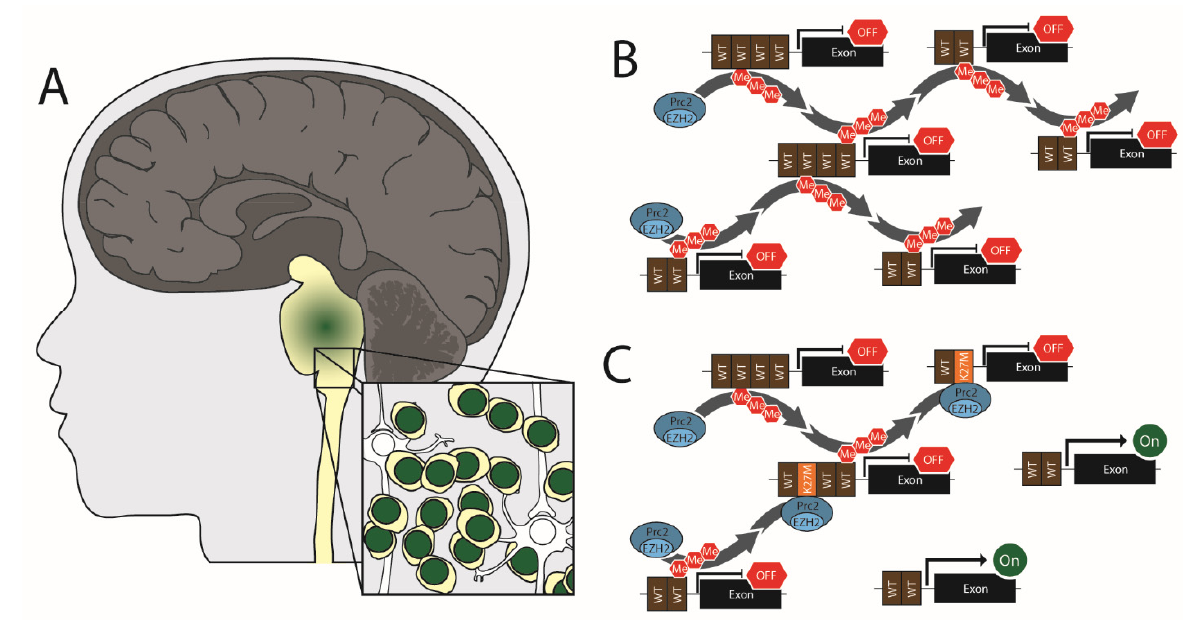
Figure 1. Pediatric Diffuse Midline Glioma. ( A ) Diffuse midline gliomas arise primarily in the pons of the brain stem. ( B ) Normal cells have mobile PRC2 complex that facilitates H3K27 triple methylation on promoter regions leading to the silencing of genes. ( C ) In DMG H3K27 altered cells, PRC2 complexes become trapped at H3 K27M loci leading to a reduced pool of active PRC2 and subsequent activation of genes.